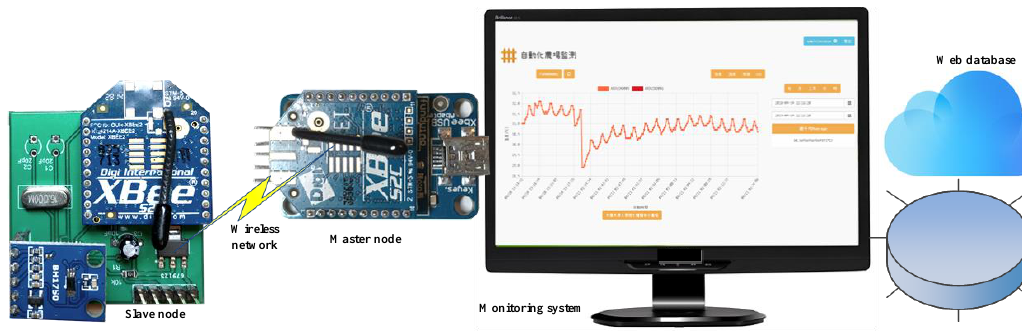
Figure 4. Hardware implementation of proposed WSN system.